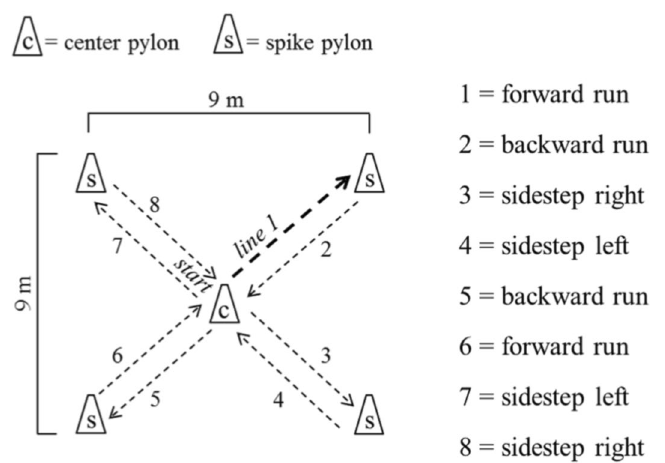
Figure 5. Schematic description of the star run test (adapted from Golle et al. 6